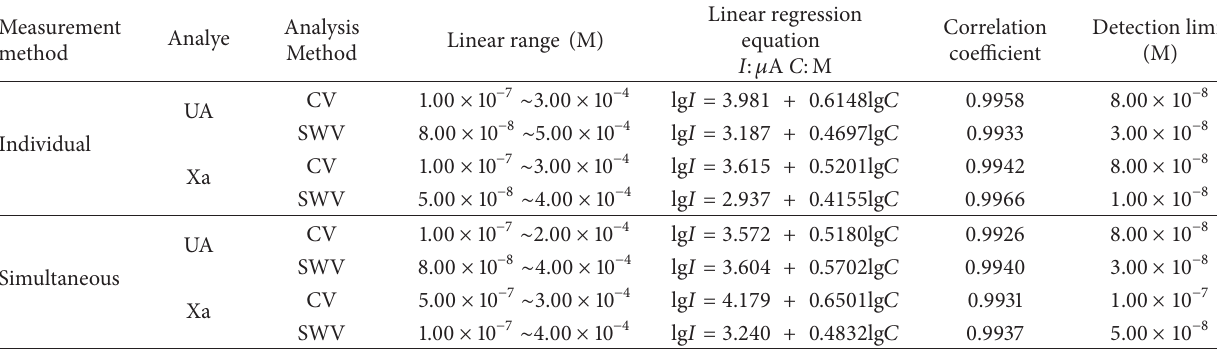
Table 4: Analytical parameters for individual and simultaneous determination of UA and Xa at PMB-ERGO/GCE. Measurement